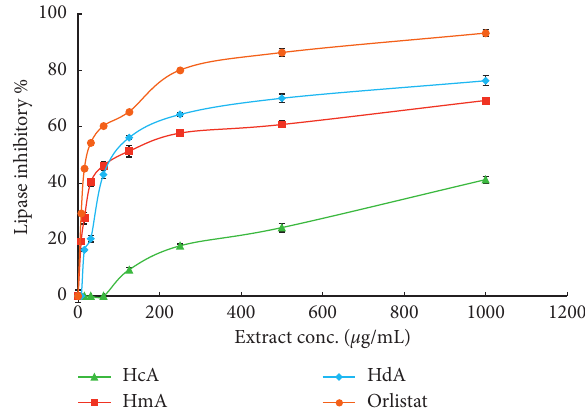
Figure 5: In vitro α -amylase inhibitory activity of aqueous extracts of tested Hibiscus deflersii (HdA), H. micranthus (HmA), and H. calyphyllus (HcA).